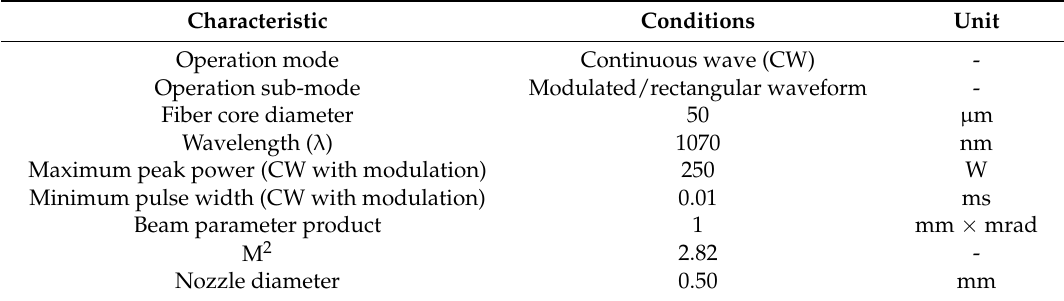
Table 3. Laser unit specifications IPG YLR-150/1500-QCW-AC.